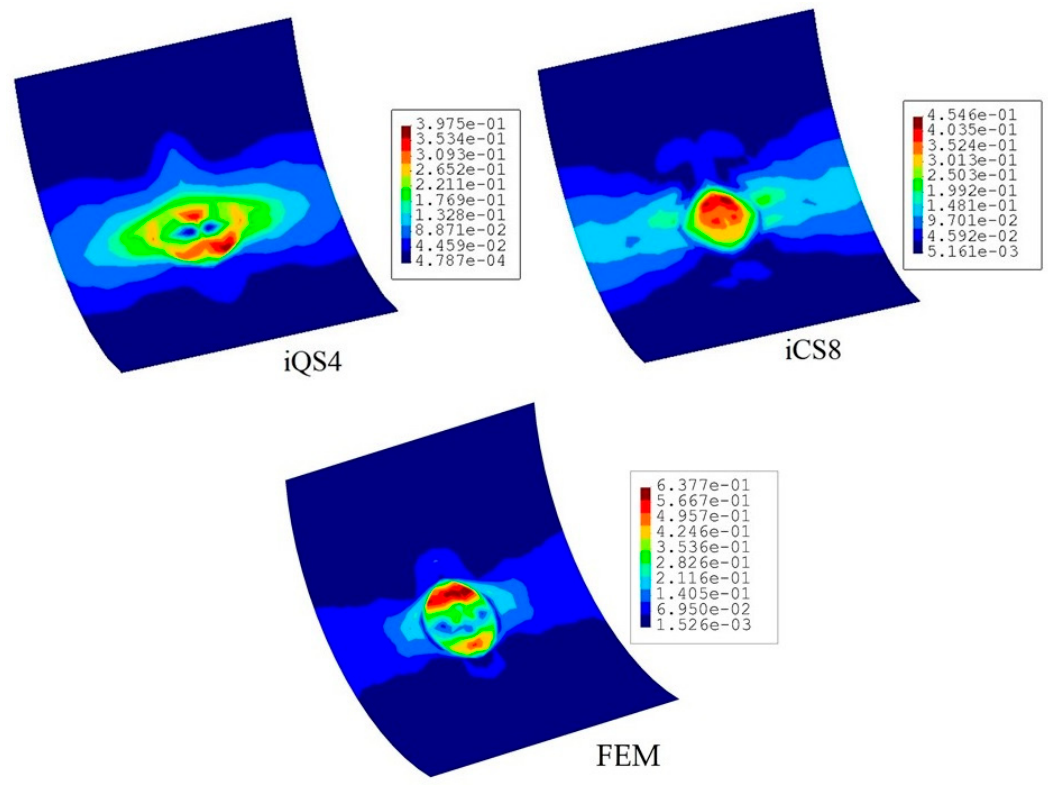
Figure 17. Contours of damage indication factor for the curved plate with a damaged